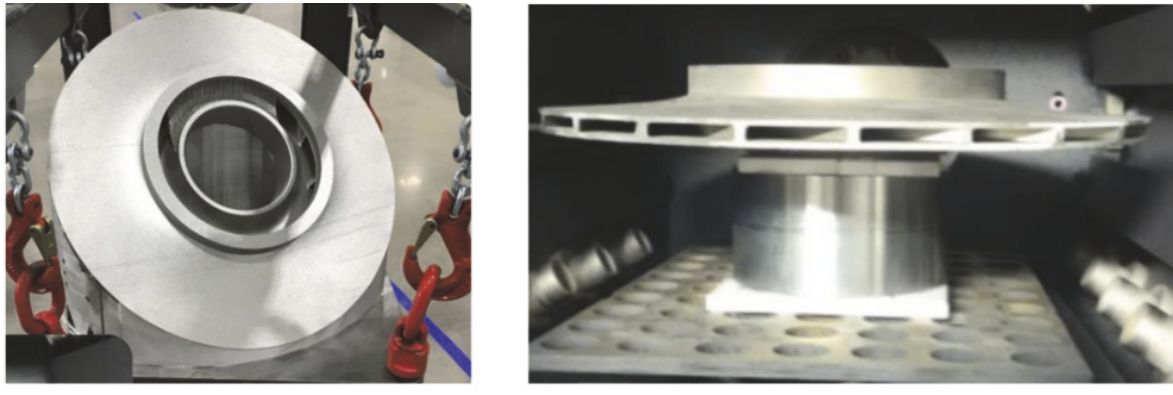
Figure 11: Final prototype of the